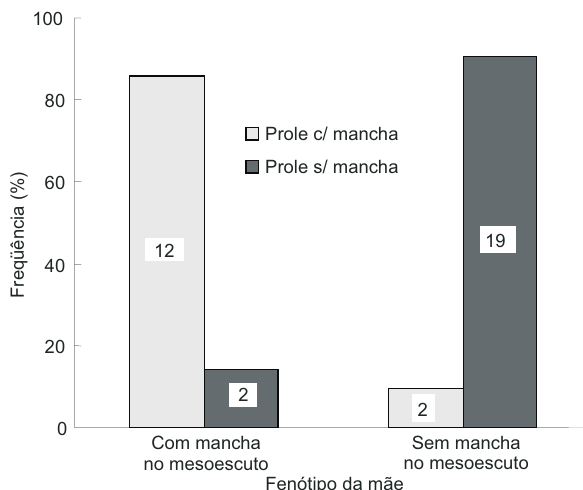
Figura 15. Relação entre o fenótipo das fêmeas de C. caligata coletadas no campo e o fenótipo da geração F tório. Número de indivíduos indicado nas